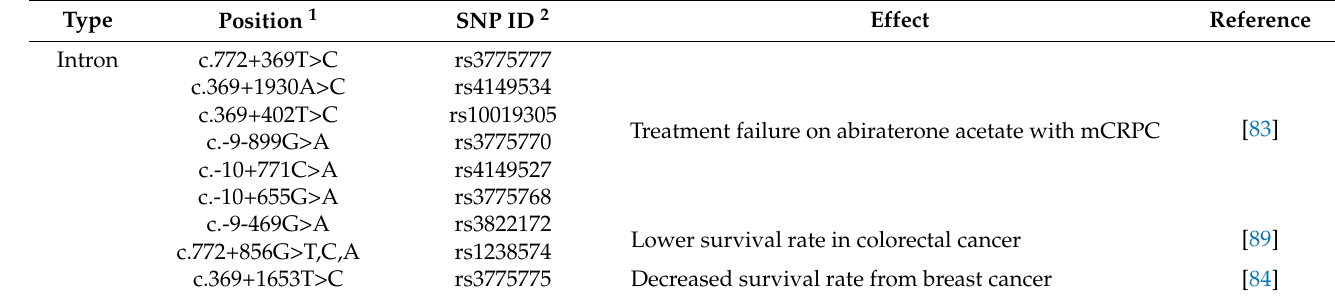
Table 5. Reported human SULT1E1 functional